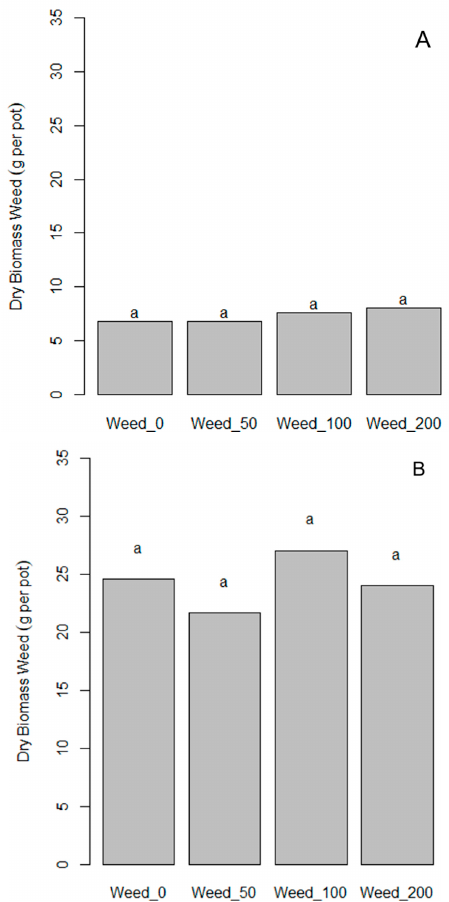
Figure 7. Weed biomass (g pot − 1 ) at Hohenheim 2020 in experiments ( A , B ), 43 days after sowing and application of ComCat ® at 50, 100, and 200 g ha − 1 in the experiments ( A , B ). A rate of 100 g ha − 1 corresponds to the recommended field rate. C = weed-free codantrol, Weed = 20 plants per pot transplanted at time of maize emergence. Means with the same letters above the columns do not differ significantly based on Tukey’s HSD test ( p ≤ 0.05).